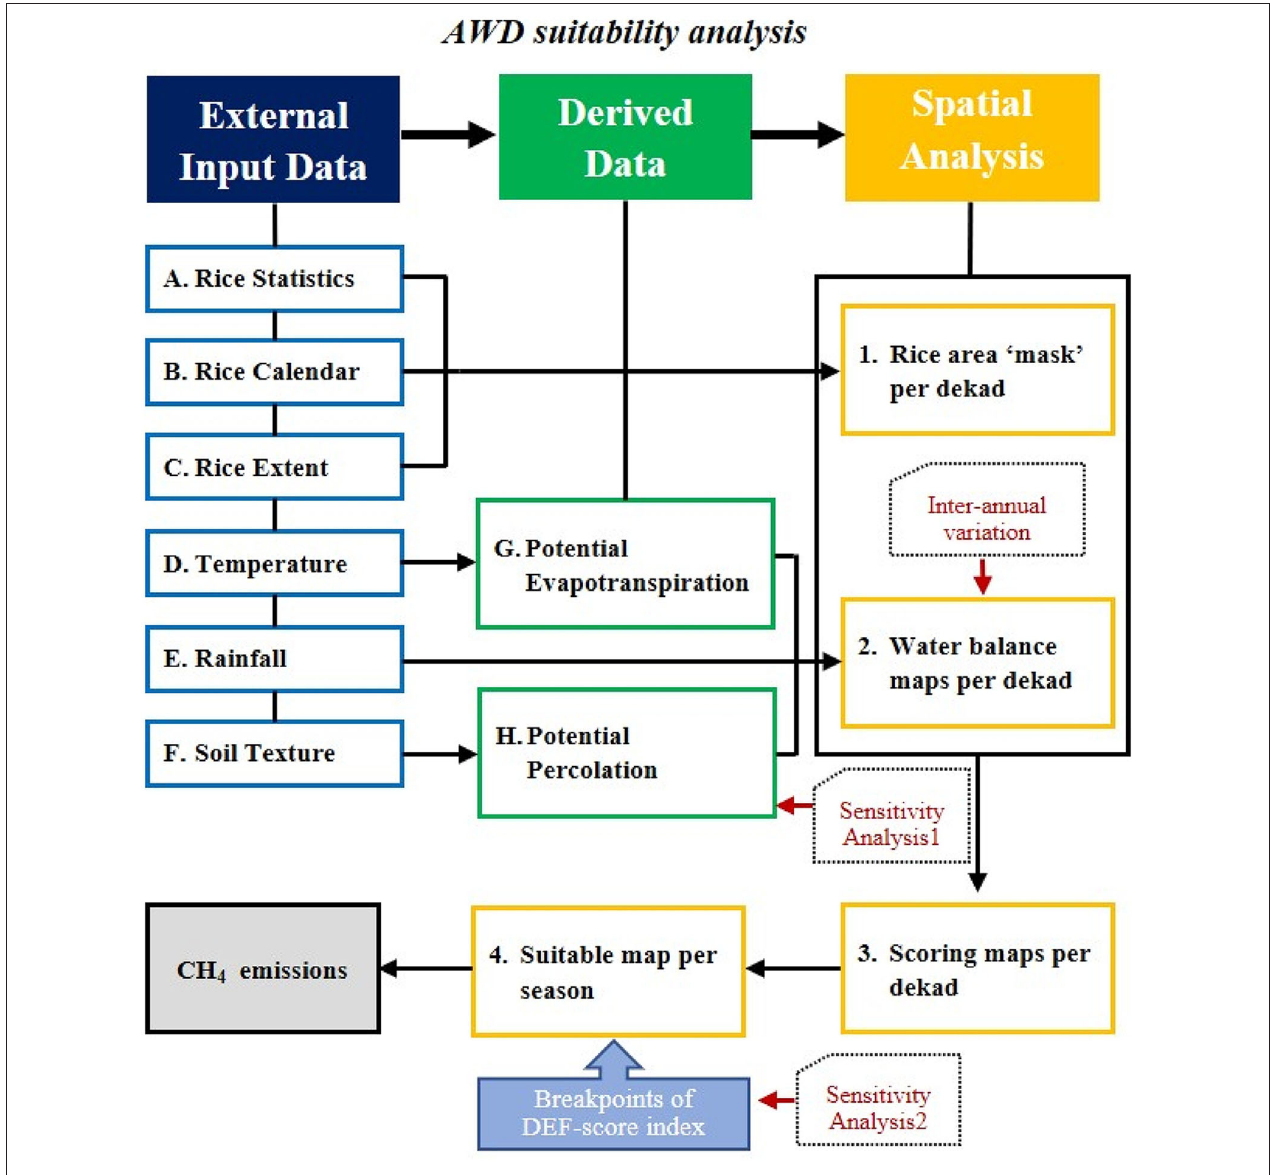
FIGURE 2 | Flow chart of the AWD suitability